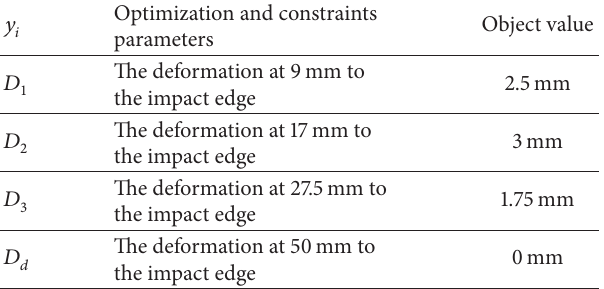
larly, the range of 𝜎 12 and 𝜏 12 at the leading/trailing edge (Figure 6(b)) can be redefined as (5.75 E + 8, 5.90 E + 8) and (5.00 E + 8, 5.20 E + 8), respectively, to narrow the searching scope of optimization and speed up the